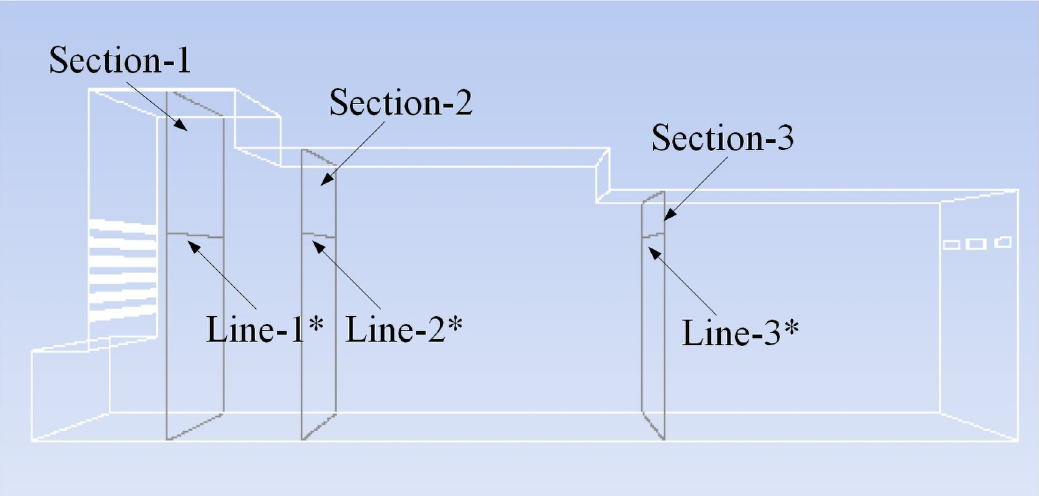
Fig 21. Selection of characteristic